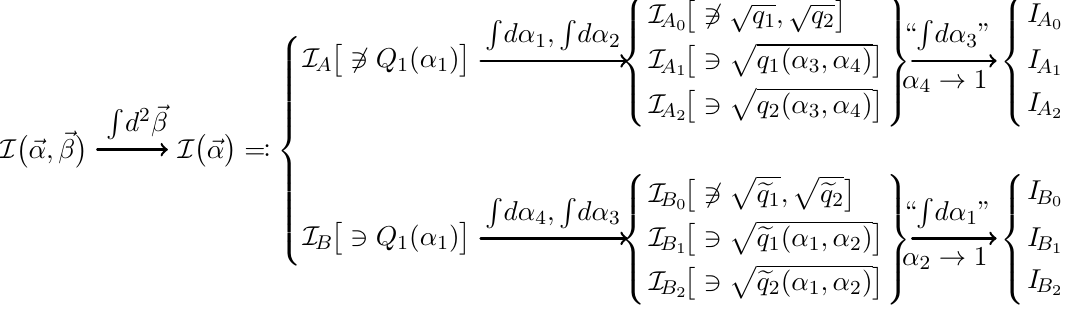
Figure 1 . Integration strategy for (cid:10)[1 ; 3 ; 5 ; 7]. Here, the (cid:12)nal integrations are written in